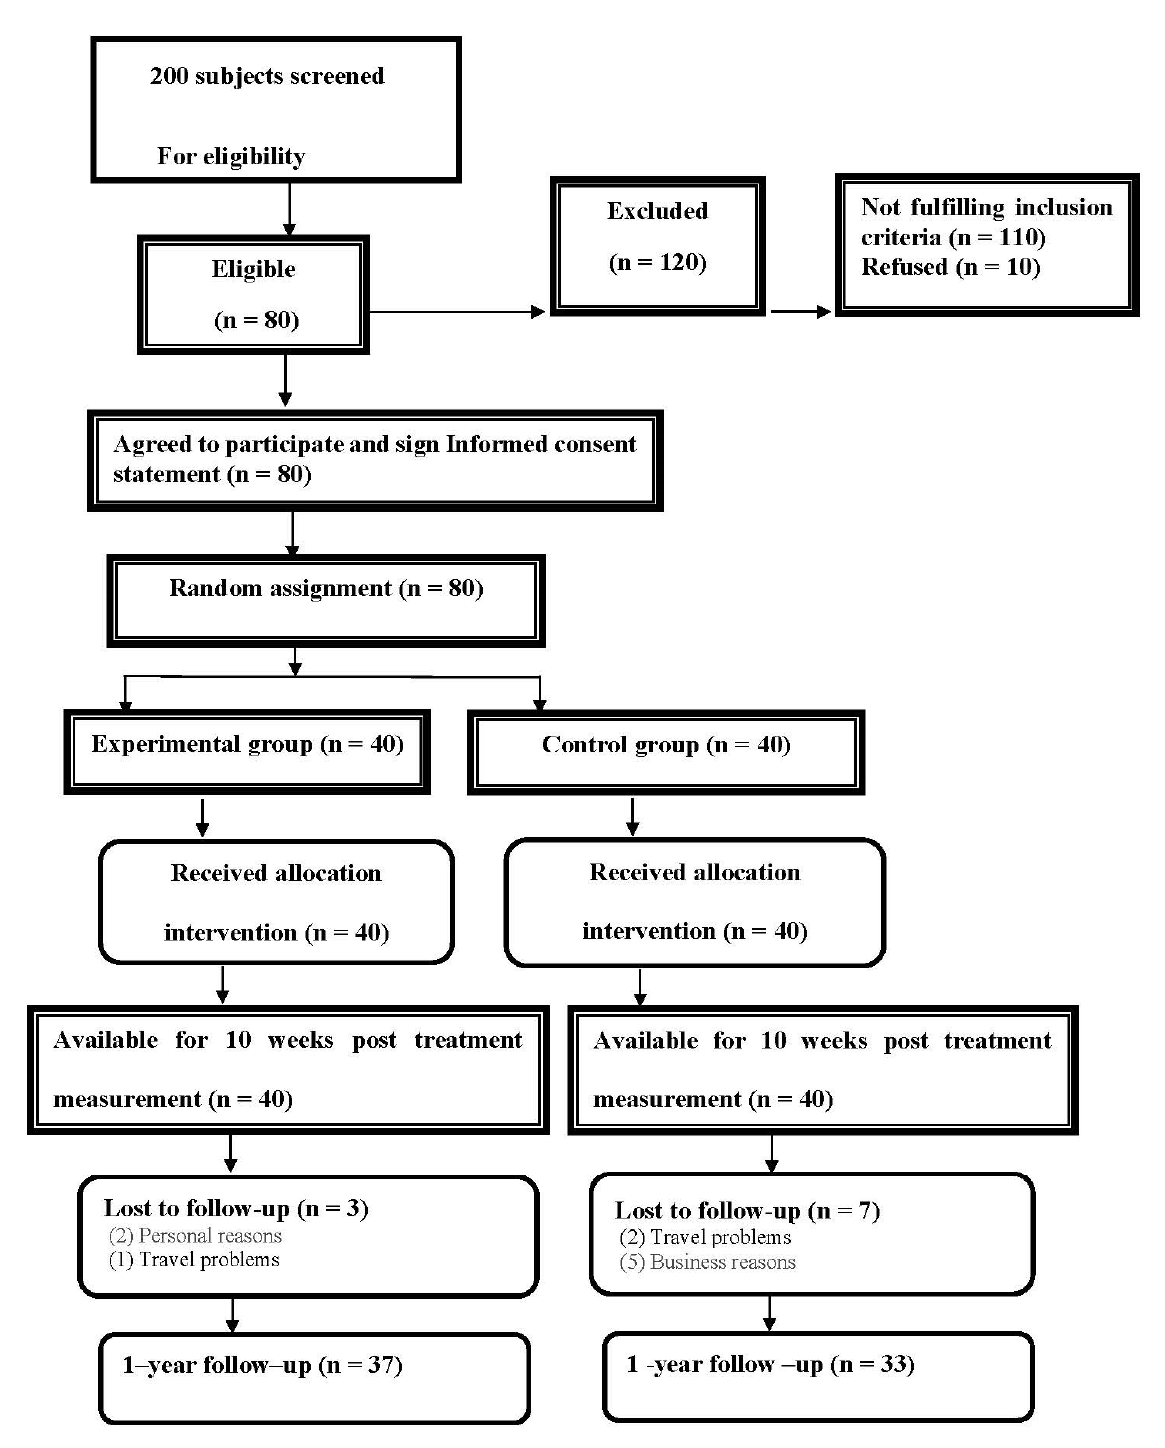
Figure 1. Flow chart of participants in the study over